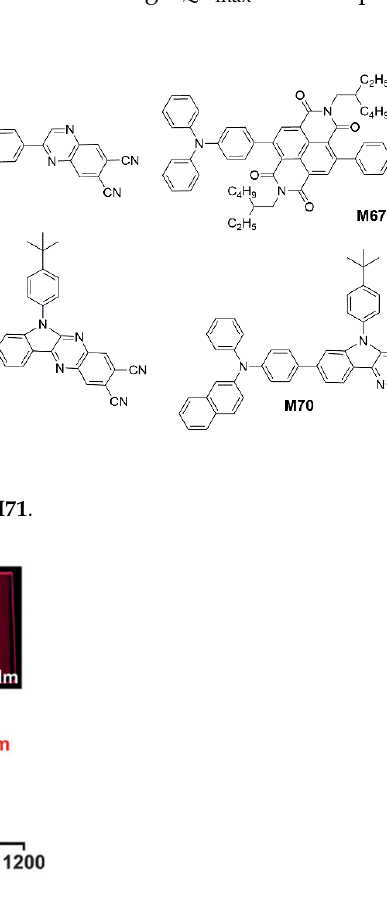
Figure 21. PL spectra of M66 crystal and neat thin film at room temperature. Inset: images of crystal and neat thin film under UV irradiation ( λ ex = 365 nm) (adapted from ref. [165]).